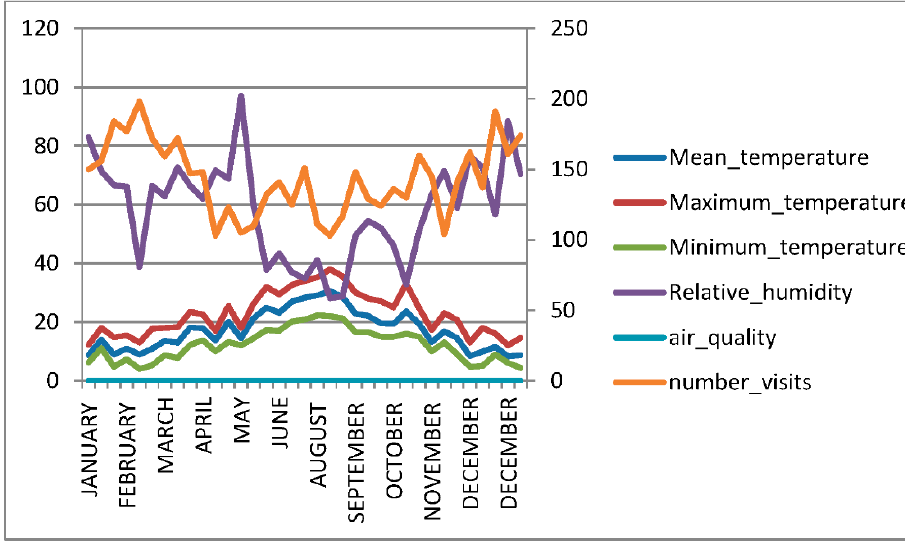
Figure 5. Relationship between the attribute target and predictors for holidays.